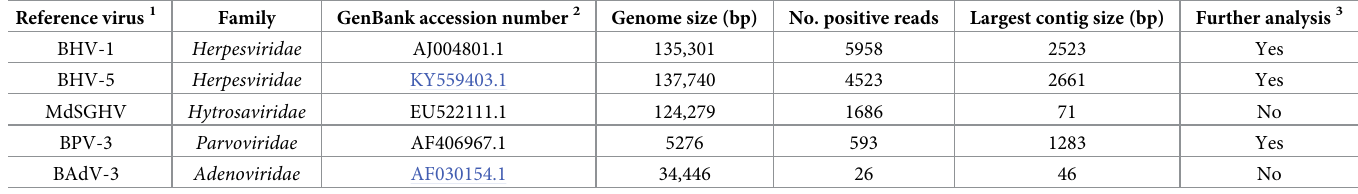
Table 1. Summary of the identified DNA